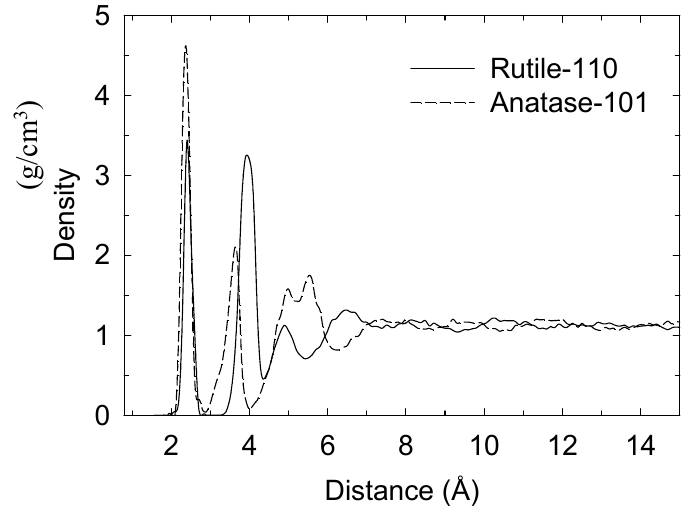
Figure 2. Density profile along z -axis of water molecules from topmost layers of titanium atoms.